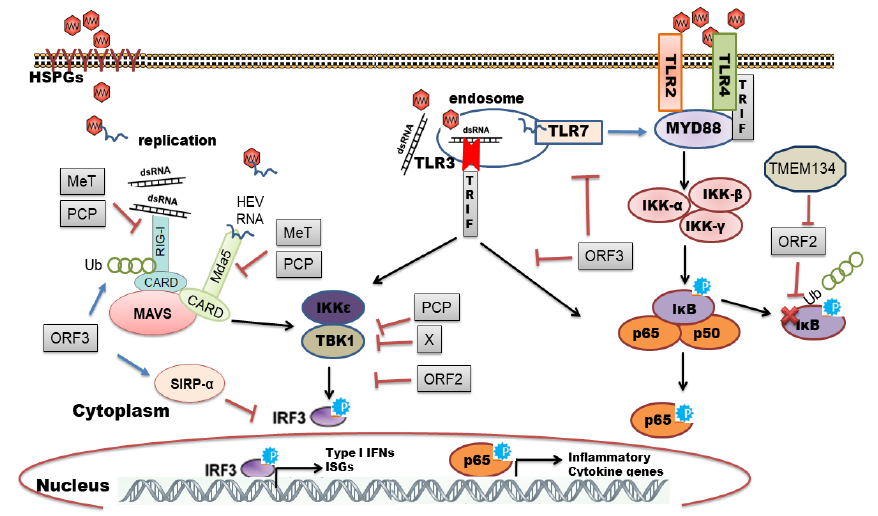
Figure 2. Recognition of Hepatitis E virus (HEV) by host cell pattern recognition receptors (PRRs) and viral strategies to evade antiviral signaling. HEV attaches to host cell heparin sulfate proteoglycans (HSPGs) and enters by clathrin-mediated endocytosis. Release of viral genomic RNA in cytoplasm and RNA replication intermediates are sensed by host cell PRRs like retinoic-inducible gene-I (RIG-I), melanoma differentiation-associated protein 5 (MDA5), and endosomal Toll-like receptor 3 (TLR3). This triggers their downstream signaling cascades, including IRF3 and NF- κ B, leading to the production of IFNs and inflammatory cytokines/chemokines. Activation of the inflammatory pathway by replication- defective (UV inactivated) virus through TLR adaptors (MyD88 and TRIF) implicates the plausible role of TLR2 and TLR4 in recognizing HEV capsid structure. On the other hand, HEV has evolved several molecular mechanisms to evade antiviral responses through interplays between viral encoded and host cell proteins. ORF1 encoded proteins PCP and MeT interfere with RLR signaling while X